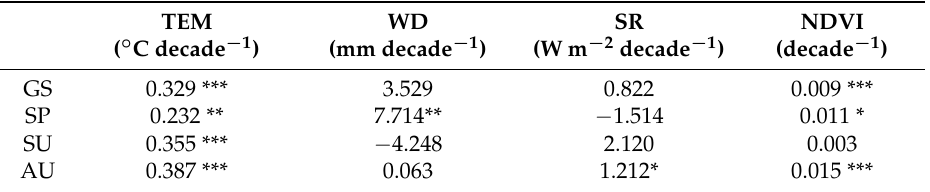
Figure 2. The linear trends of regional mean Normalized Difference Vegetation Index (NDVI) in different seasons over northeastern China in period of 1982 to 2015. ( a – d ) is for growing season, spring, summer and autumn, respectively. Shaded areas represent the 95% confidence intervals of the linear trends, and *, ** and *** represent the significance of linear fitting, which indicate statistical significance at p < 0.1, p < 0.05 and p < 0.01, respectively, with Student’s t -test. Table 2. The linear trends of regional mean NDVI, temperature (TEM), water deficit index (WD), and solar radiation (SR) in different